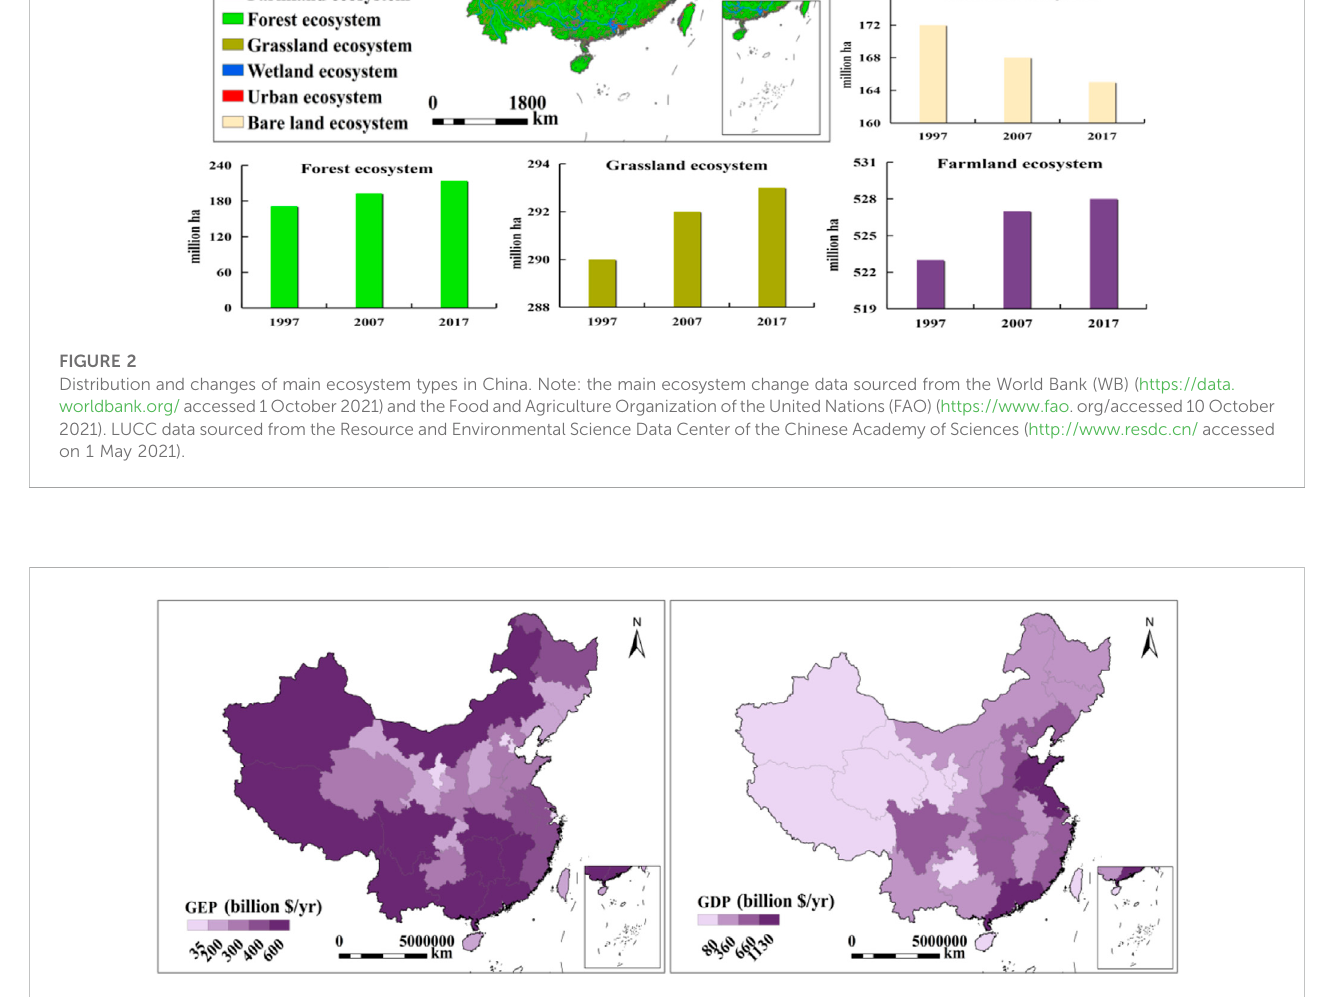
FIGURE 3 China ’ s GEP and GDP in 2015. Note: GDP data sourced from the World Bank (WB) (https://data. worldbank.org/accessed 1 October 2021) and United Nations Statistics Division (UNSD) (https://unstats.un.org/ accessed 1 October